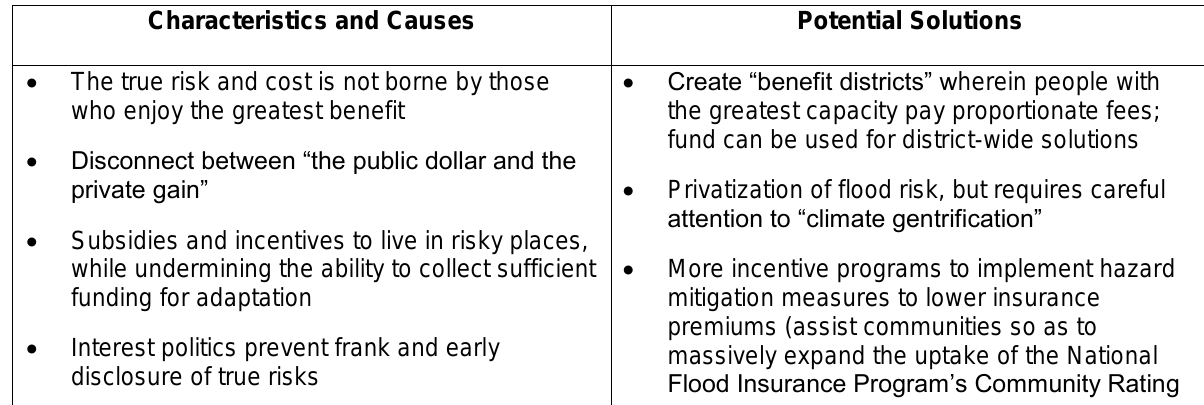
Table A2.6: Characteristics, Underlying Causes and Potential Solutions to